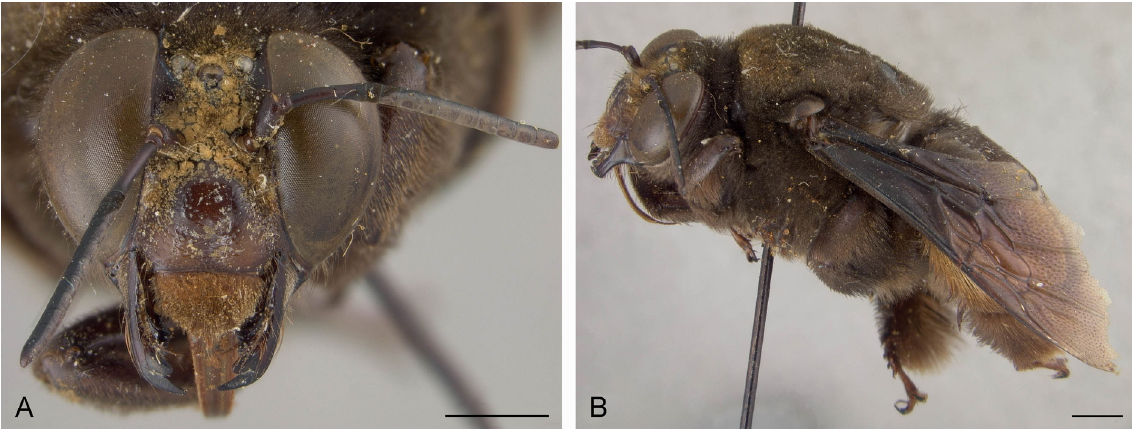
Fig. 19. Centris fusciventris matoensis Cockerell, 1919, holotype, ♂ (NMNH; USNM ENT 00534203). A . Frontal view. B . Habitus, lateral view. Scale bars: A = 1 mm; B = 2